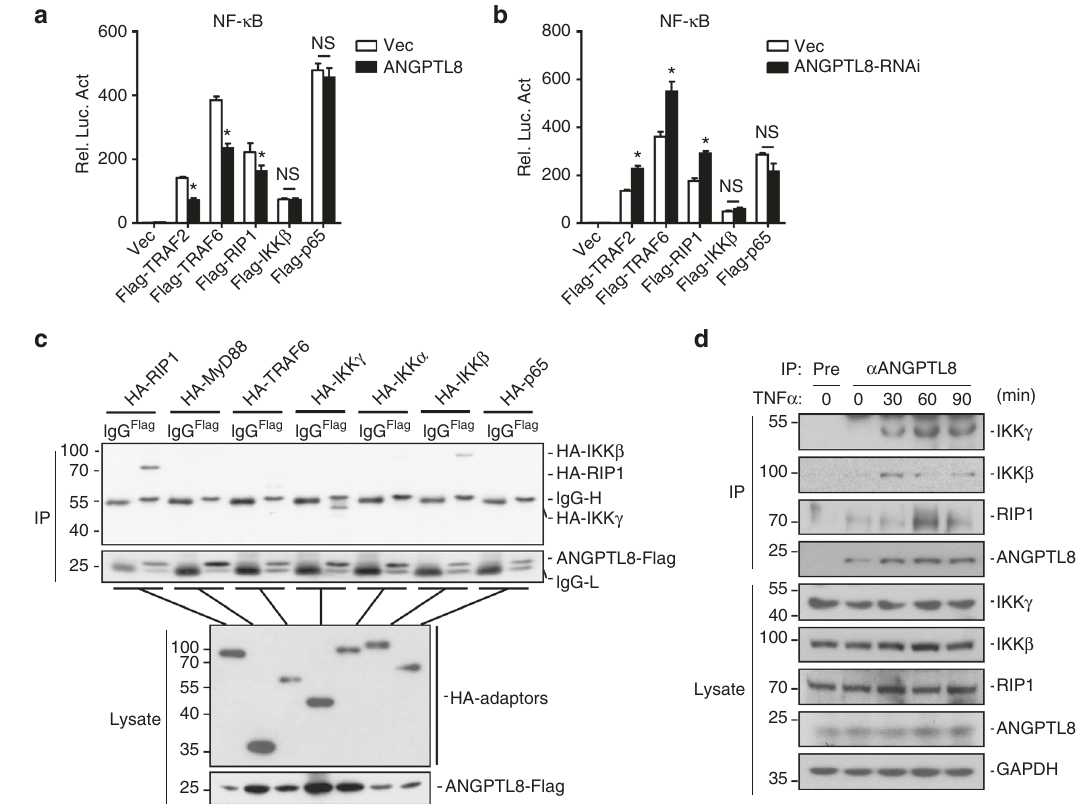
Fig. 4 ANGPTL8 regulates TNF α -induced NF- κ B activation at the IKK complex level. a Effects of the ANGPTL8 overexpression on Flag-TRAF2-, Flag- TRAF6-, Flag-RIP1-, Flag-IKK β - or Flag-p65-mediated NF- κ B activation. HEK293T cells were transfected with a control vector or ANGPTL8-Flag expression plasmid (0.05 μ g) and the indicated plasmids (0.1 μ g of TRAF2 or IKK β , 0.01 μ g of TRAF6, RIP1 or p65). Reporter assays were performed 20 h after transfection ( n = 3). b Effects of the ANGPTL8-RNAi on Flag-TRAF2-, Flag-TRAF6-, Flag-RIP1-, Flag-IKK β - or Flag-p65-mediated NF- κ B activation. HEK293T cells were transfected with a control vector or ANGPTL8-RNAi-#3 plasmid (0.3 μ g) for 24 h before being transfected with the indicated plasmids. Twenty hours later, the cells were lysed and reporter assays were performed ( n = 3). c ANGPTL8 interacts with IKK γ , IKK β and RIP1 in the mammalian overexpression system. d Endogenous ANGPTL8 interacts with IKK γ , IKK β and RIP1 in HepG2 cells. Data are shown as the mean ±